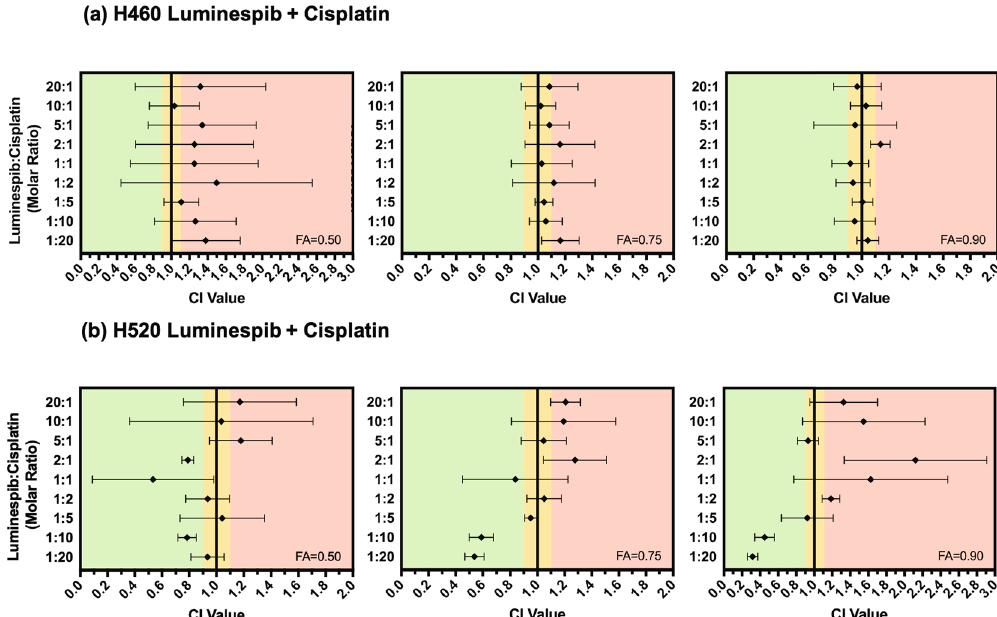
Figure 4. CI values for H460 ( a ) and H520 ( b ) cells treated with various molar ratios of LUM + CDDP at fraction affected ( FA ) = 0.50, 0.75, and 0.90. Data are presented as mean and SD (n = 3). CI values < 0.90 indicate that the two drugs act synergistically (shown in green) while CI values of 0.90–1.10 indicate an additive effect (shown in yellow), and CI values > 1.10 indicate that the two drugs act antagonistically (shown in red). The combination was found to be mostly additive and antagonistic in both cell lines, except 1:10 and 1:20 LUM:CDDP, which were found to have a synergistic effect in H520 cells.